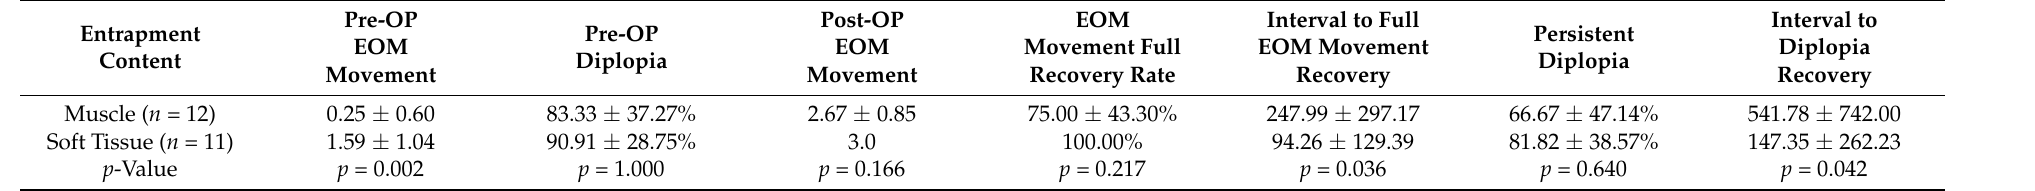
Table 5. Comparison of functional outcome by entrapment